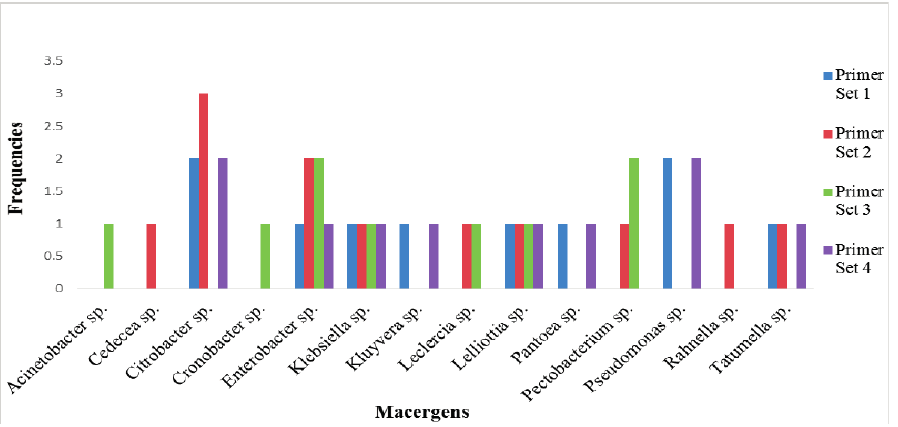
Figure 3. Selective frequencies of the primer with respect to the macergens in the